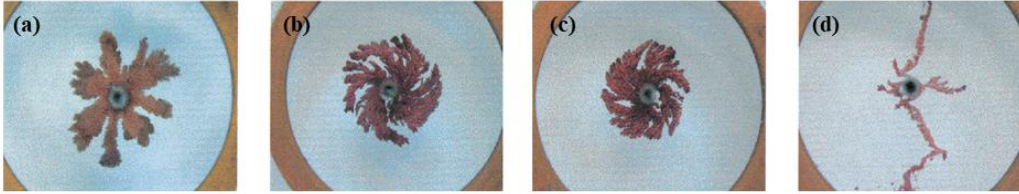
Figure 3. Morphology of copper electrodeposits grown around a central cathode in a horizontal flat circular cell ( a ) in zero applied field, ( b ) 0.4 T vertically upward, ( c ) 0.4 T vertically downward, and ( d ) 1 T horizontally (Reproduced with permission from [21]. American Chemical Society, 2001).